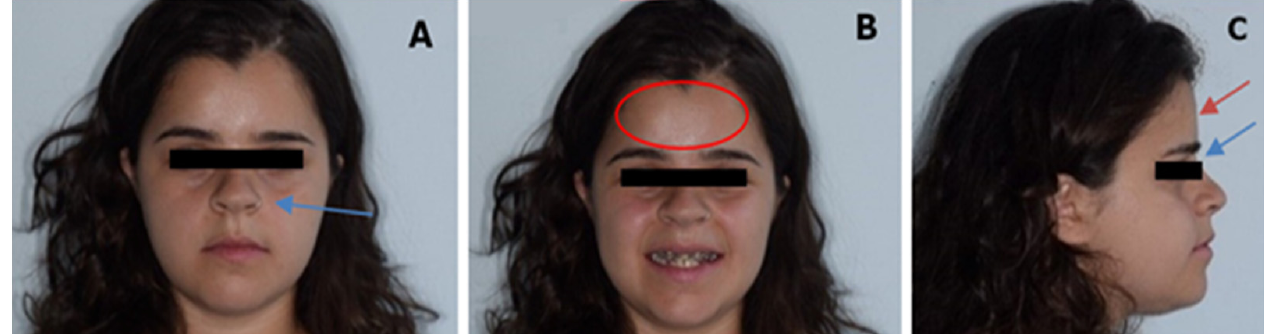
Figure 1. ( A ) Frontal photo, ( B ) frontal smiling photo, ( C ) lateral photo. Broad forehead and flat frontal bone (circle B and arrow C), depressed nasal bridge (blue arrow C) and wide alar base (blue arrow A). The patient appeared to be in good health with normal intelligence. Th dental anam-